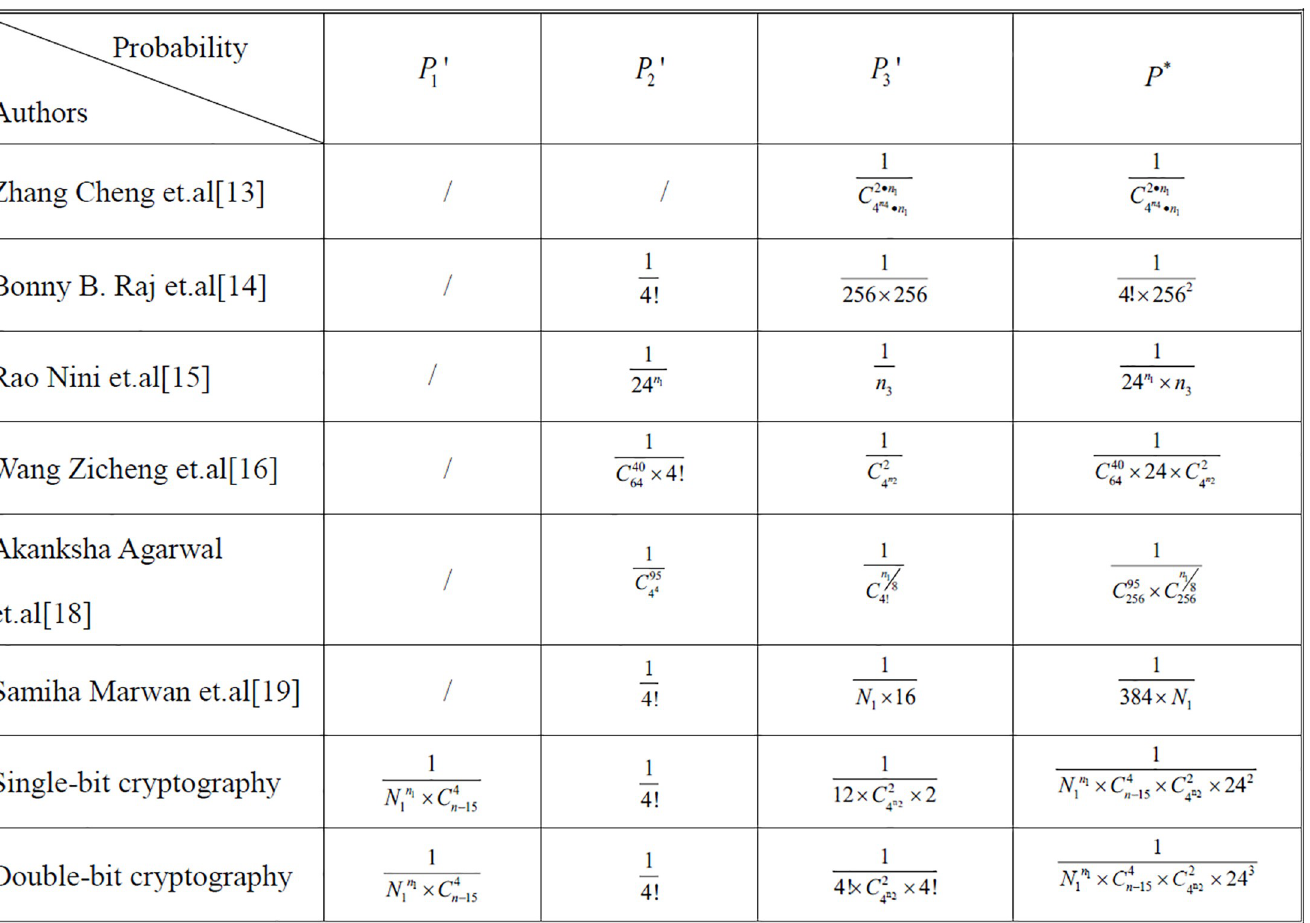
Fig 8. Comparisons of the probability of selection and cracking (here, n 1 -the length of plaintext binary; n 2 -the length of primer information; n 3 -the total number of ring DNA; n 4 -the length of the key).